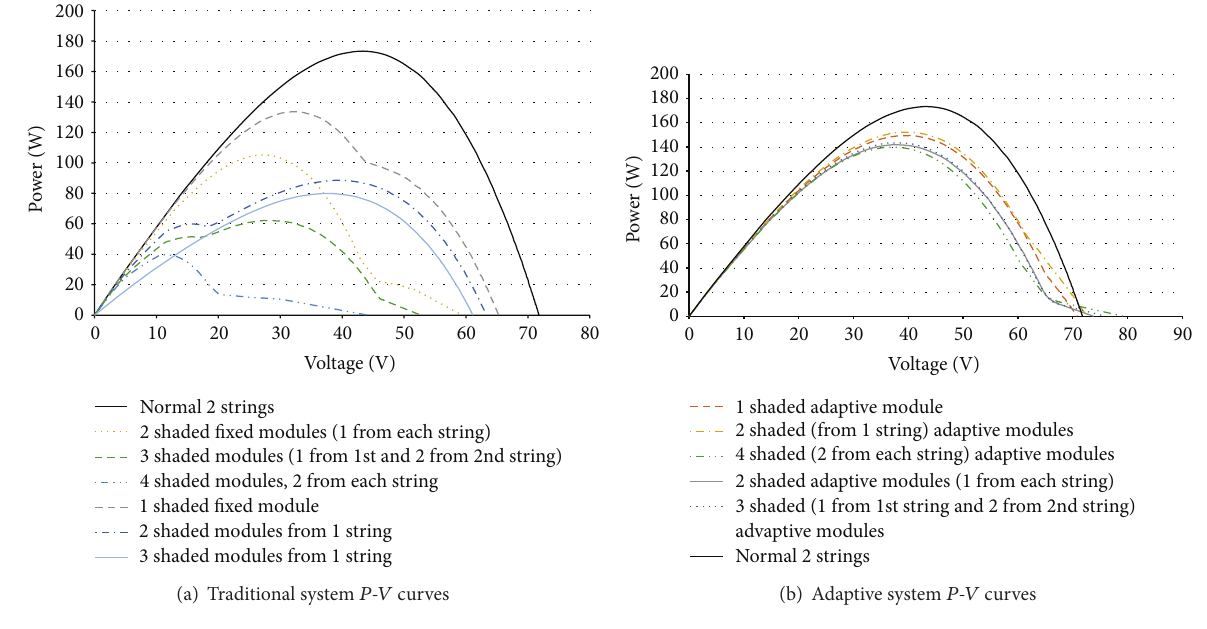
Figure 5: Simulation results for traditional and proposed systems for various shading patterns.